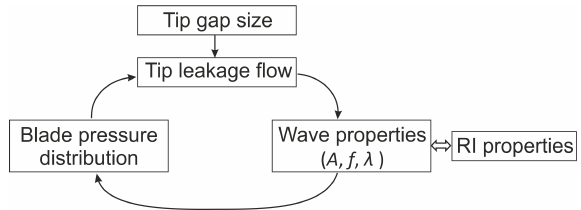
Figure 14. RI-mechanism